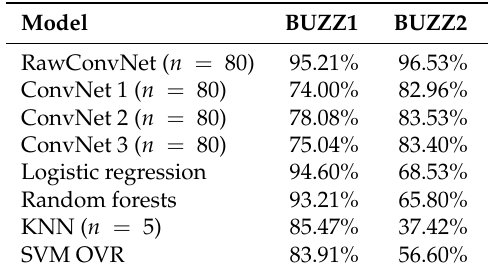
Table 23. Summary of validation accuracies on BUZZ1 and BUZZ2 validation